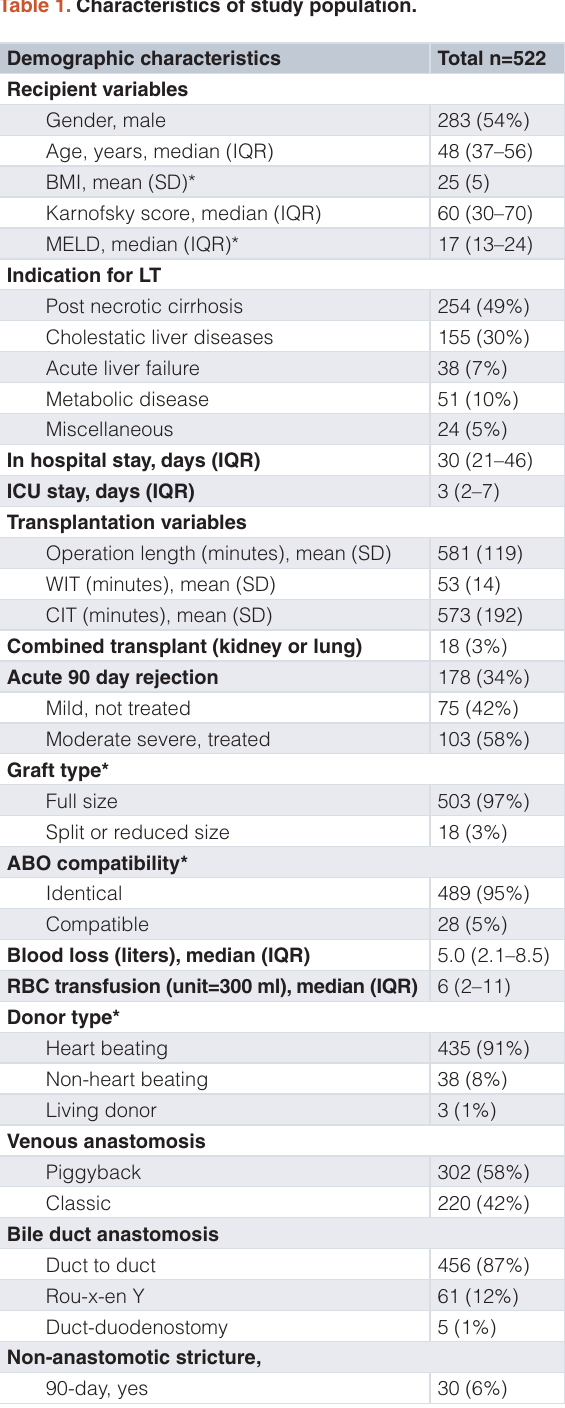
Table 1. Characteristics of study